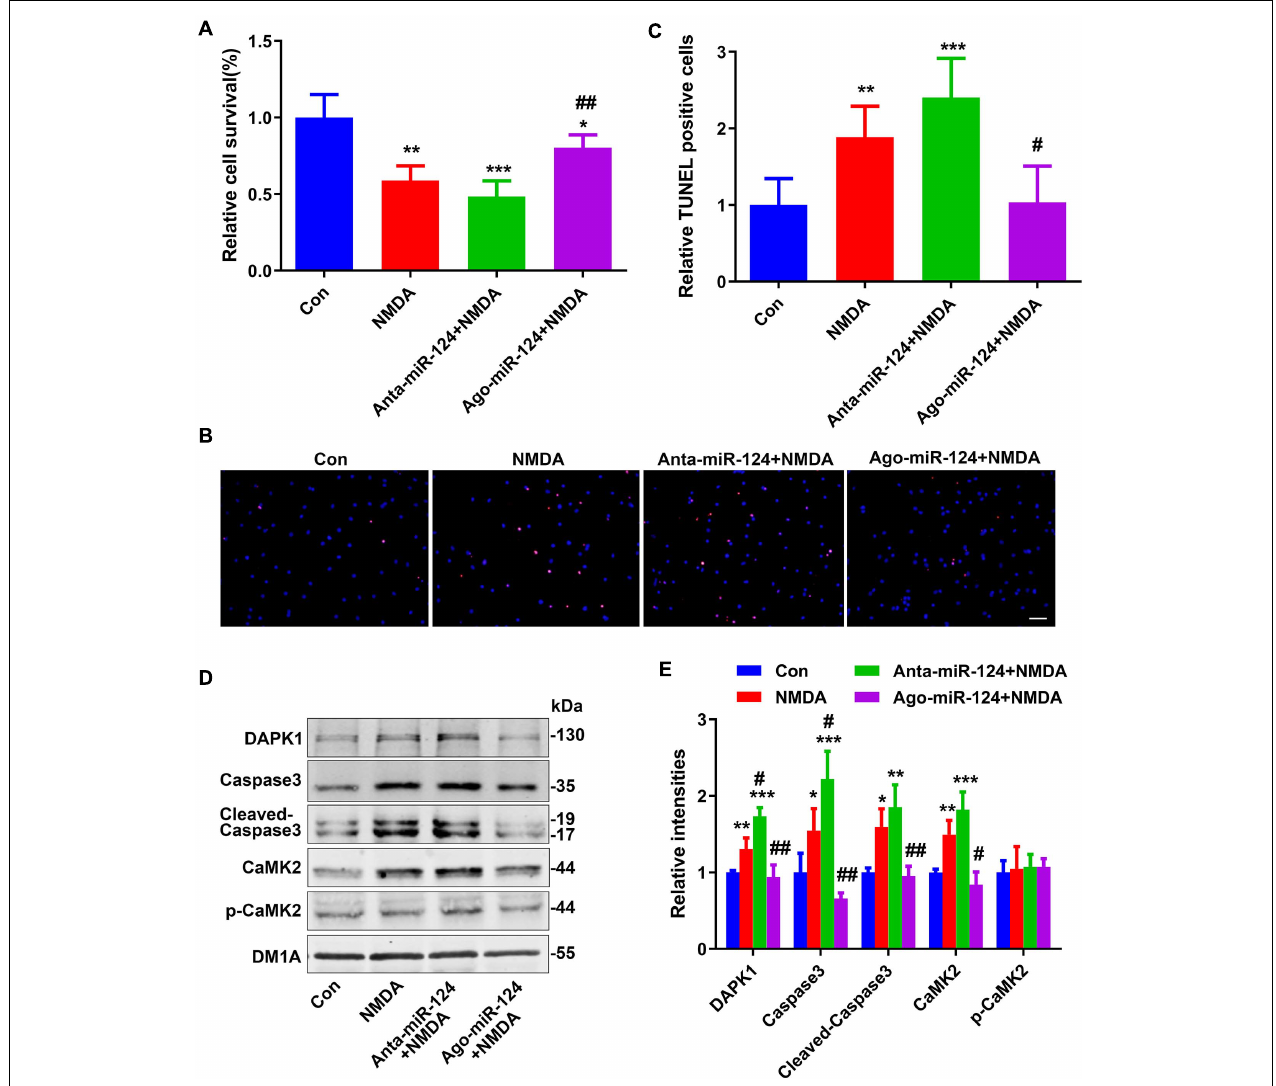
FIGURE 3 | Protective effect of miR-124 on neuroexcitatory toxicity. (A) The relative cell viabilities of primary cultured neurons were evaluated using a cell counting kit-8 (CCK8) assay after NMDA treatment (20 µ M for 15 min) ( n = 6/group). (B) TUNEL staining was performed in primary cultured neurons after NMDA treatment with different miR-124 levels (scale bar = 50 µ m) and quantified (C) . Levels of DAPK1, caspase-3, cleaved caspase-3, CaMK2, and p-CaMK2 were measured by western blotting (D) and quantitatively analyzed (E) . Data are presented as mean ± SD ( n = 4/group). * p < 0.05, ** p < 0.01, ***p < 0.001 vs. Con, # p < 0.05, ## p < 0.01 vs. NMDA